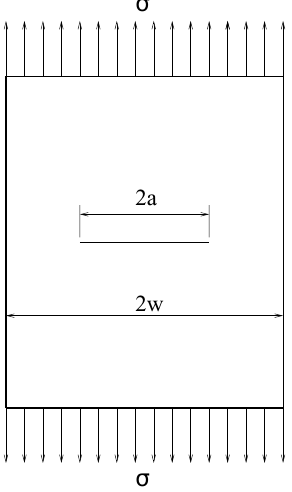
Fig. 1. Finite plate with central mode 1 crack under uniaxial